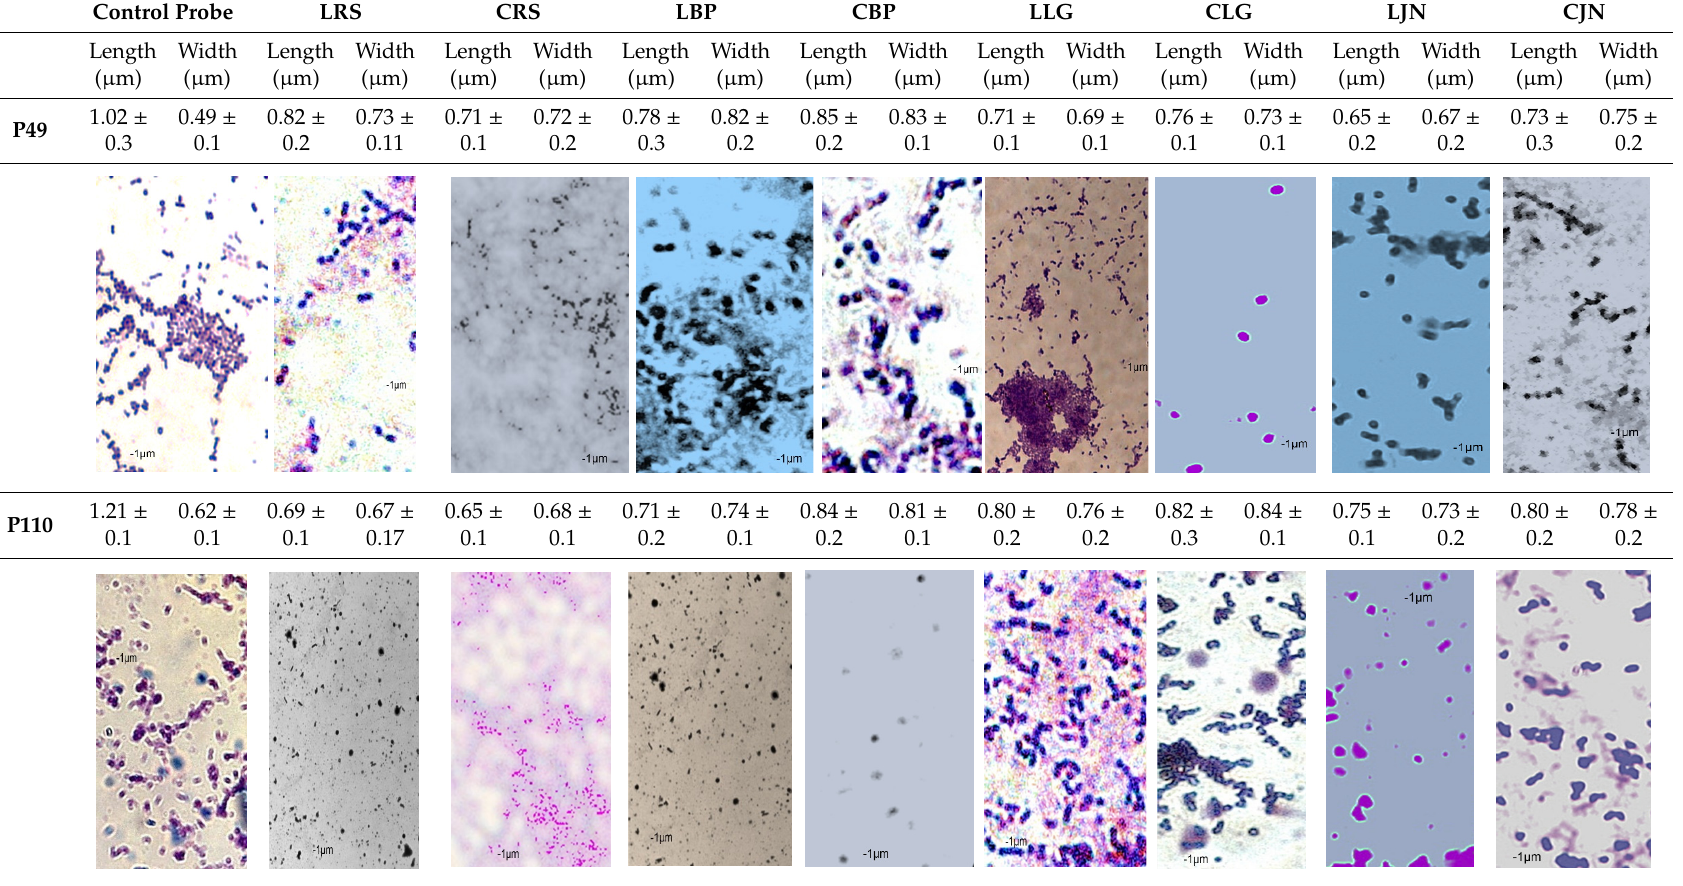
Table 5. Cells’ morphological changes under the influence of essential oils. CRS—commercial rosemary oil, LRS—laboratory rosemary oil, CBP—commercial black pepper oil, LBP—